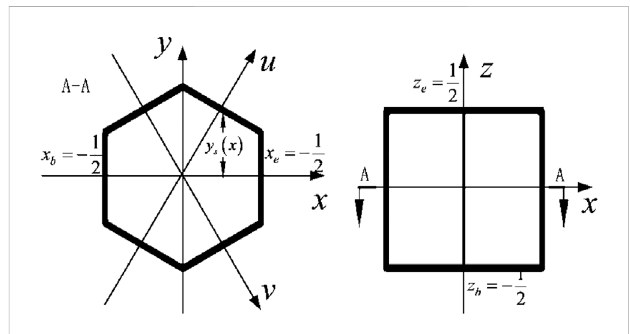
FIGURE 1 Hexagonal prism in the calculated coordinate